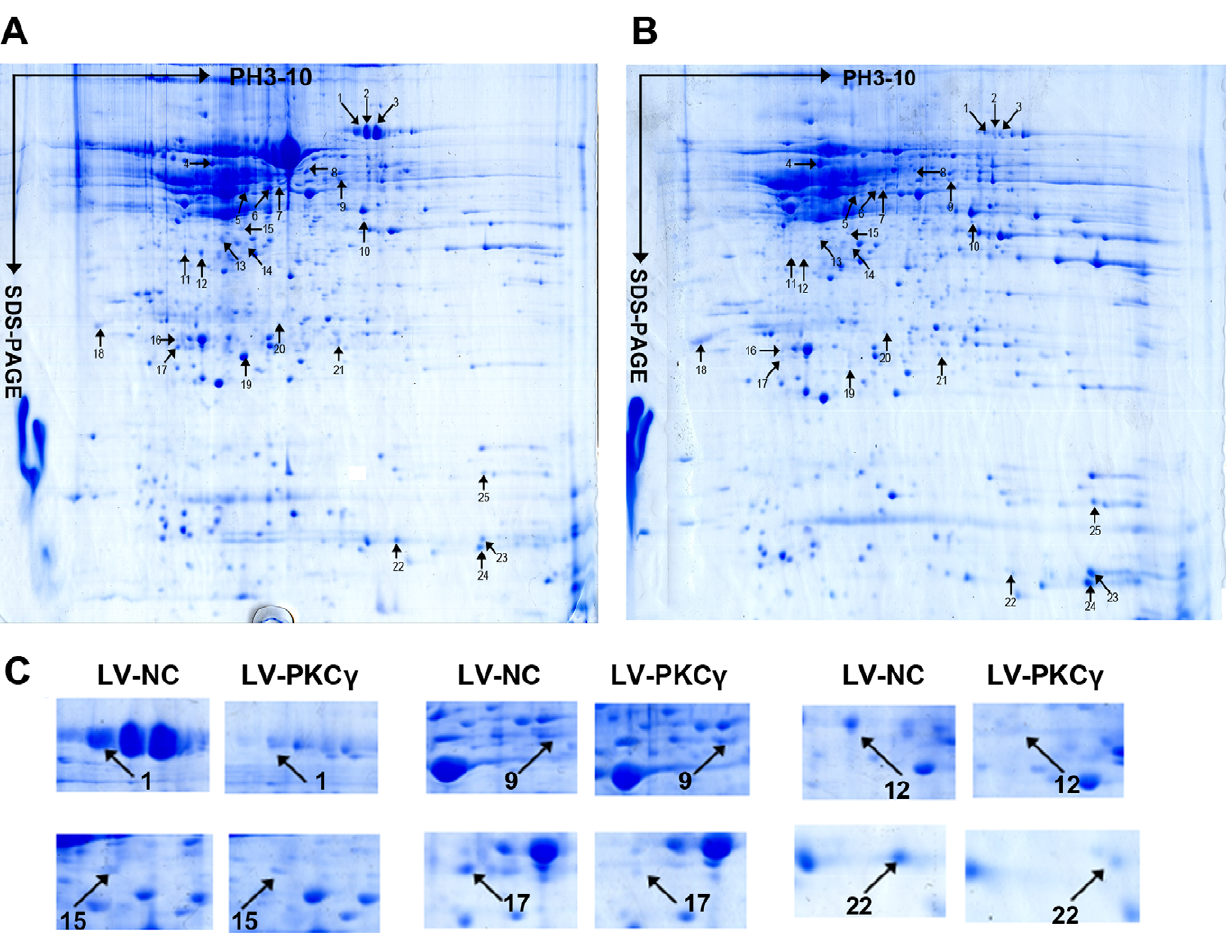
Figure 3. 2DE images of the intumescentia lumbaris from the spinal cords of LV-NC- (A) or LV-shPKCa˜- (B) treated morphine- tolerant rats. Proteins were separated on a pH 4-7 IPG strip in the first dimension, and on an SDS-polyacrylamide (12%) gel in the second dimension. (C) Close-up image of partial differential expression protein spots, between LV-NC and LV-shPKCa˜.